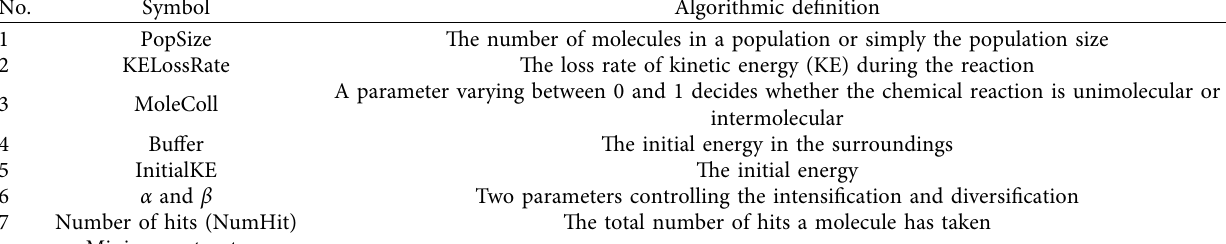
Table 1: Parameters of